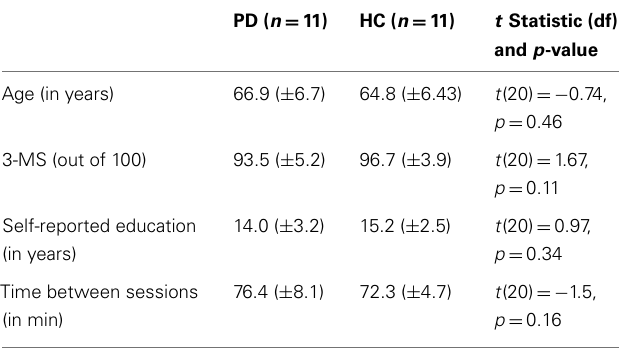
Table 4 | Statistical comparisons of age, education, 3-MS, and time between sessions of PD and healthy comparison (HC) participants.